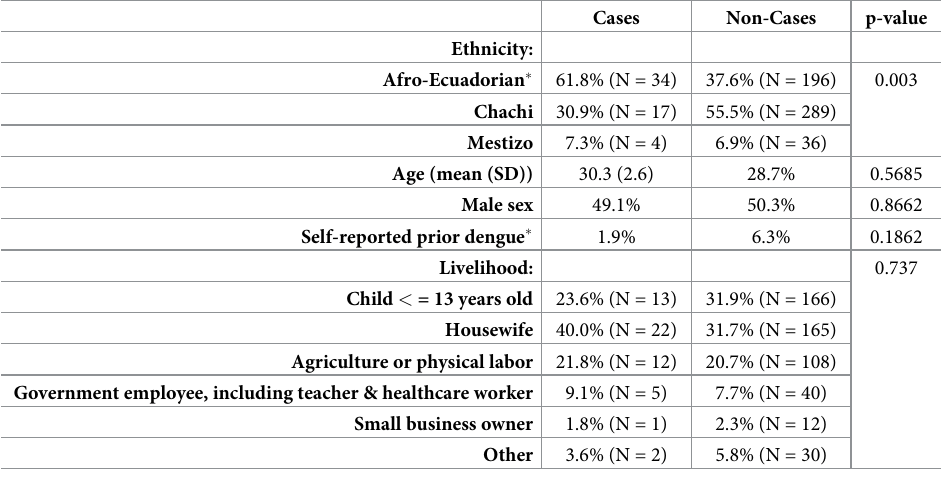
Table 2. Characteristics of